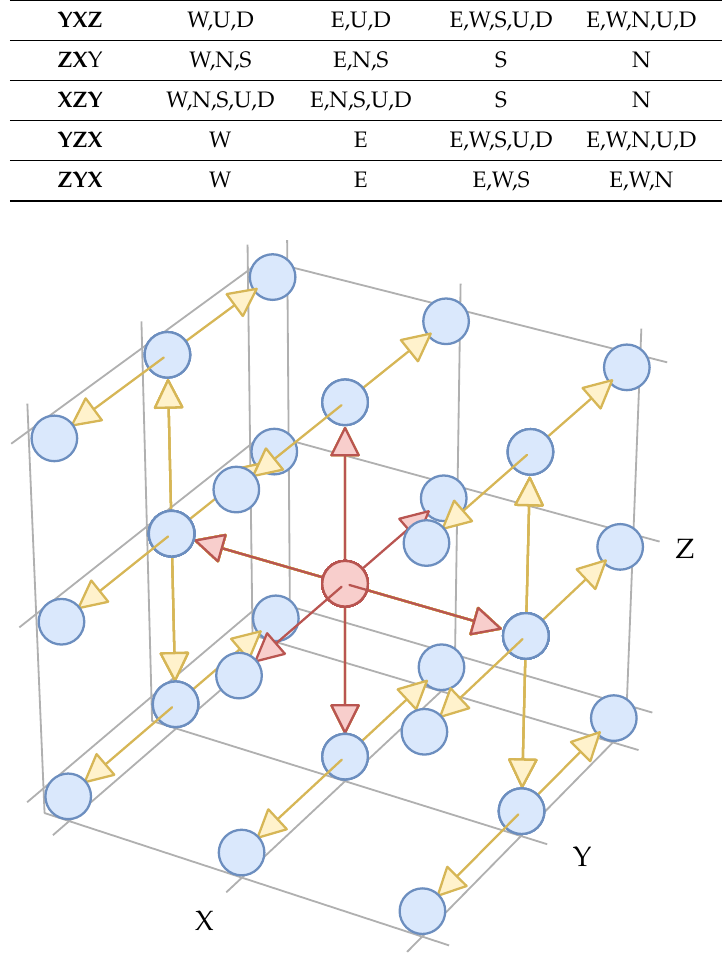
Figure 4. XZY broadcast mechanism example from the BMU at position ( 2,2,2 ) shown in red, to all others neurons (in blue) of a 3 × 3 × 3 network. Red arrows represent the BMU broadcast special case and yellow arrows represent the paths followed by XZY broadcast mechanism.